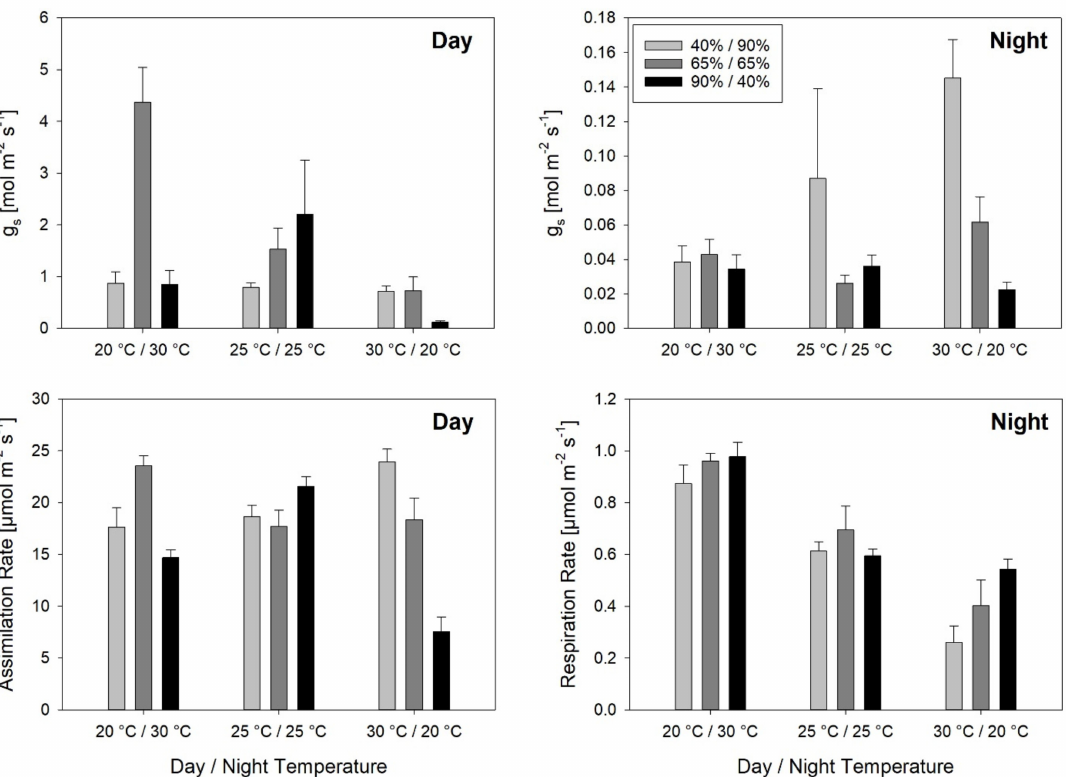
Figure 2. Stomatal conductance during day and night, assimilation and respiration rate of the youngest fully developed leaf of plants grown at varying day and night temperature and RH regimes. Measurements were performed during 24 h in 3–5 repetitions. Error bars are standard errors of the mean value. Table 5. Analysis of variance for stomatal conductance (g s ) and assimilation rate during day